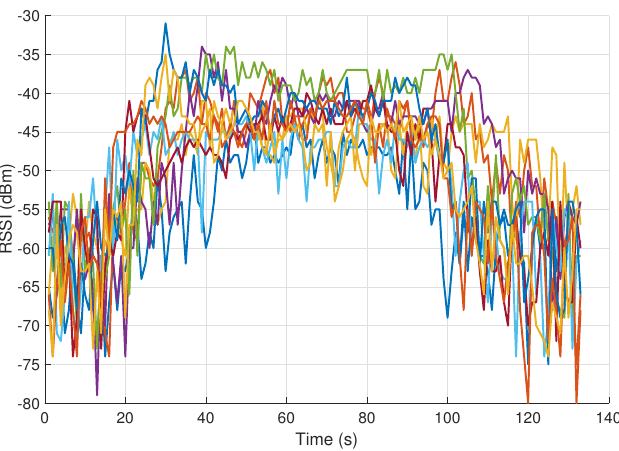
Figure 5. RSSI signals in dBm measurements associated with shoulder scratching (10 different signals representing the same hand movement